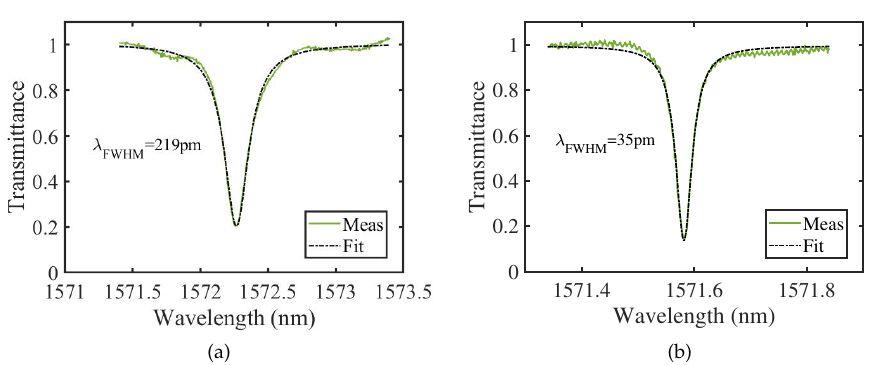
Figure 5. Transmittance of the optical microring resonators that are fabricated in the ( a ) unpolished and ( b ) polished 4H-SiCOI chips.